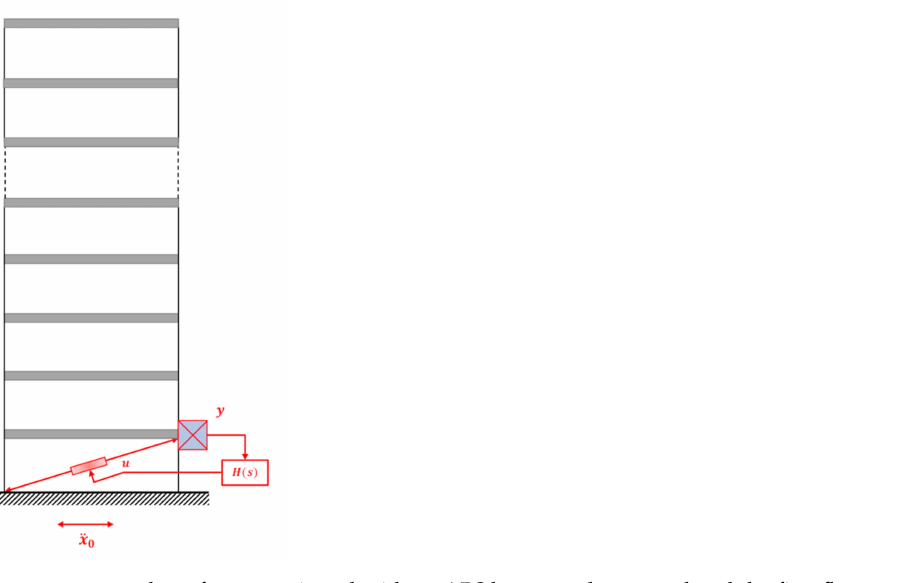
Figure 17. n-story shear frame equipped with an ABS between the ground and the first